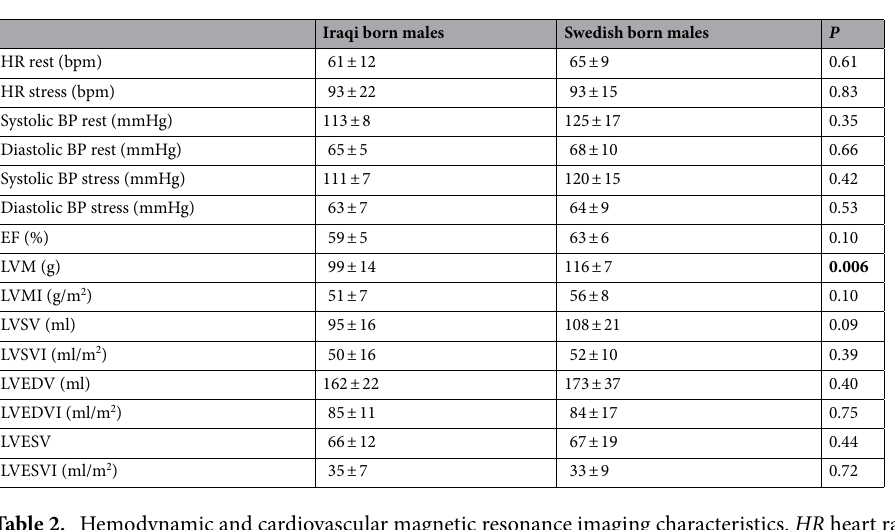
males and Swedish healthy controls at rest (7026 ± 1489 vs 7291 ± 2573, P = 0.72) and stress (10403 ± 2563 vs 11016 ± 1437, P = 0.46). The difference between stress and rest RPP did not differ between groups (3377 ± 1609 vs 3724 ± 3077, P = 0.68) indicating similar hemodynamic responses to adenosine stress. Framingham risk score for coronary heart disease was similar for Iraqi and Swedish males (4.0% vs 4.3%, P = 0.75) reflecting low CVD risk within the next decade in both Iraqi and Swedish born men. The SCORE risk score showed similar results (1.3% vs 1.5%, P = 0.79). Myocardial perfusion. Quantitative first pass perfusion. Global flow from qFPP analysis demonstrated no statistically significant difference between groups in resting perfusion (0.8 ± 0.2 vs 1.0 ± 0.4 ml/min/g, P = 0.38) or RPP corrected resting perfusion (1.2 ± 0.5 vs 1.1 ± 0.2 ml/min/g × [mmHg × bpm/10 4 ] −1 , P = 0.59). However, perfusion during adenosine was lower in Iraqi males (2.9 ± 0.7 vs 3.5 ± 0.7 ml/min/g. P = 0.02), see Fig. 3. If a cutoff of 2.25 ml/min/g for a decreased absolute perfusion was used (dashed horizontal line in Fig. 3) three Iraqi subjects demonstrated signs of microvascular disease. MPR did not show any statistically significant difference between groups (3.9 ± 1.0 vs 4.3 ± 1.2 ml/min/g, P = 0.42) or with RPP corrected resting perfusion (2.8 ± 1.0 vs 3.3 ± 0.8 ml/min/g × [mmHg × bpm/10 4 ] −1 , P = 0.14). There was also a significant difference between Iraqi and Swedish subjects in qFPP per mass of myocytes (4.0 ± 1.0 vs 4.8 ± 1.0 ml/min/g, P = 0.03).